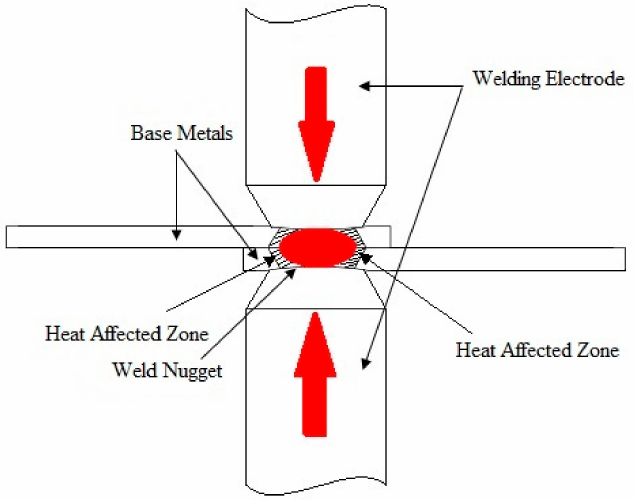
Figure 1. Resistance spot welding (RSW) scheme.